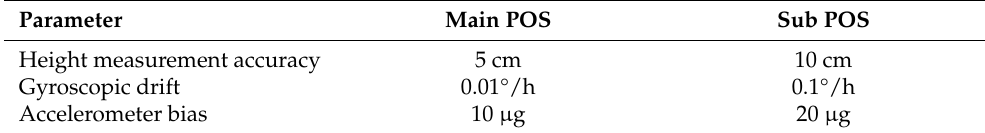
Table 2. The parameters of distributed POS.